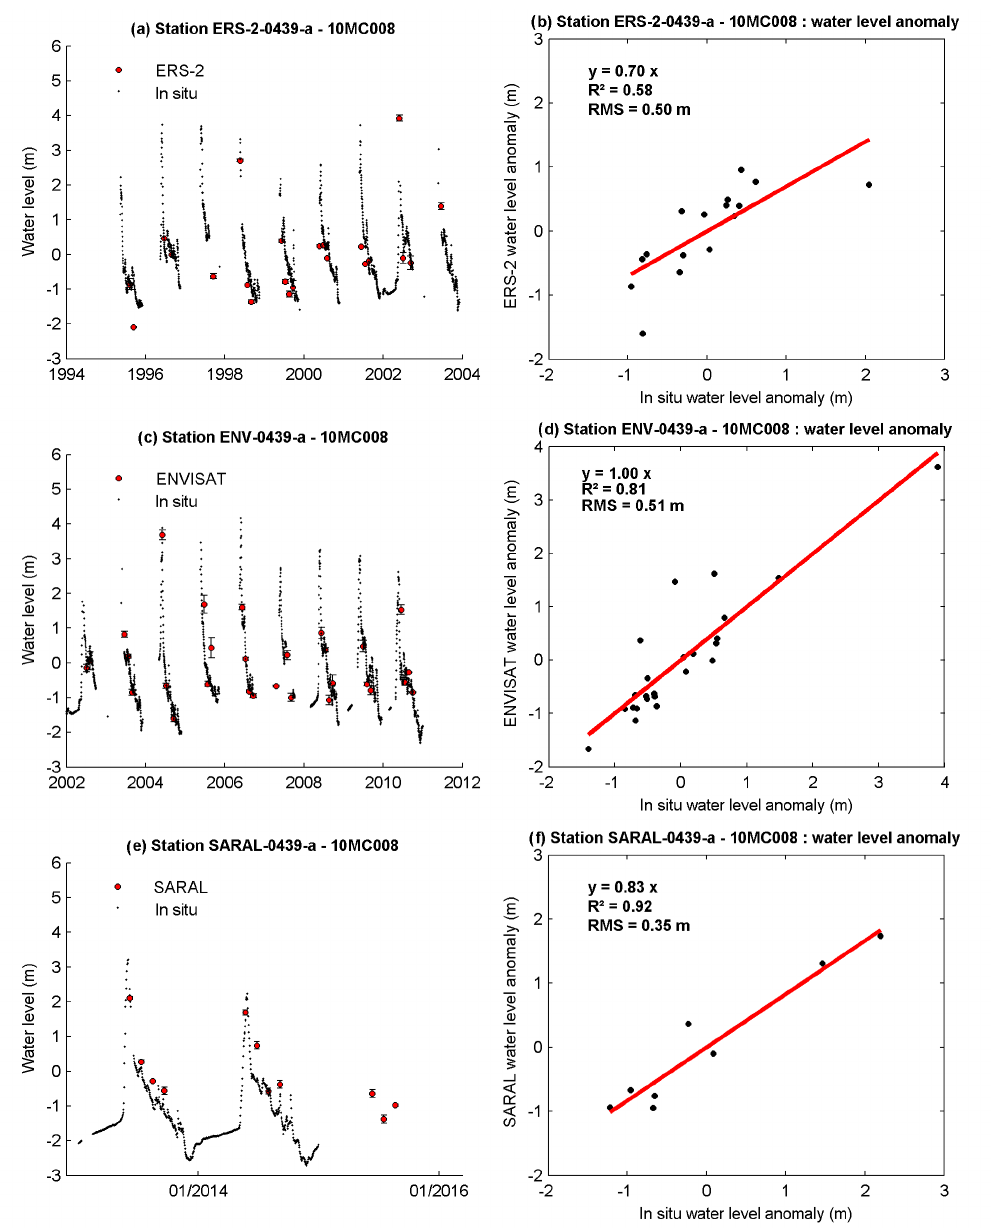
Figure 7. Altimetry-based water levels from 1995 to 2015 compared with in situ water levels for the station 0439-a located in the centre of the Mackenzie Delta using (a) the ERS-2 mission and (b) a water level anomaly with statistic parameters, (c) the ENVISAT mission and (d) a water level anomaly with statistic parameters, and (e) the SARAL mission and (f) a water level anomaly with statistic